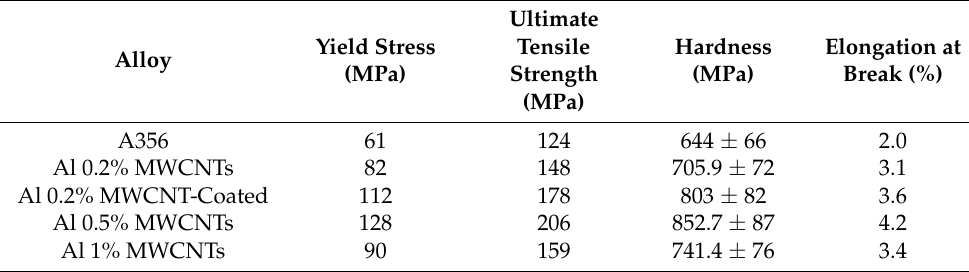
Table 3. Mechanical characteristics of the A356 aluminum alloy and fabricated nanocomposites.